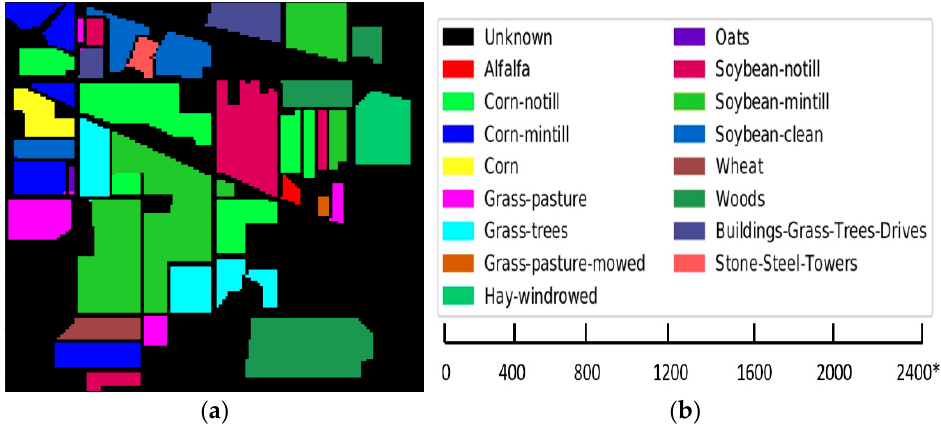
Figure 5. Proposed overall block diagram of SE-AB-DenseNet with cutout classifier.